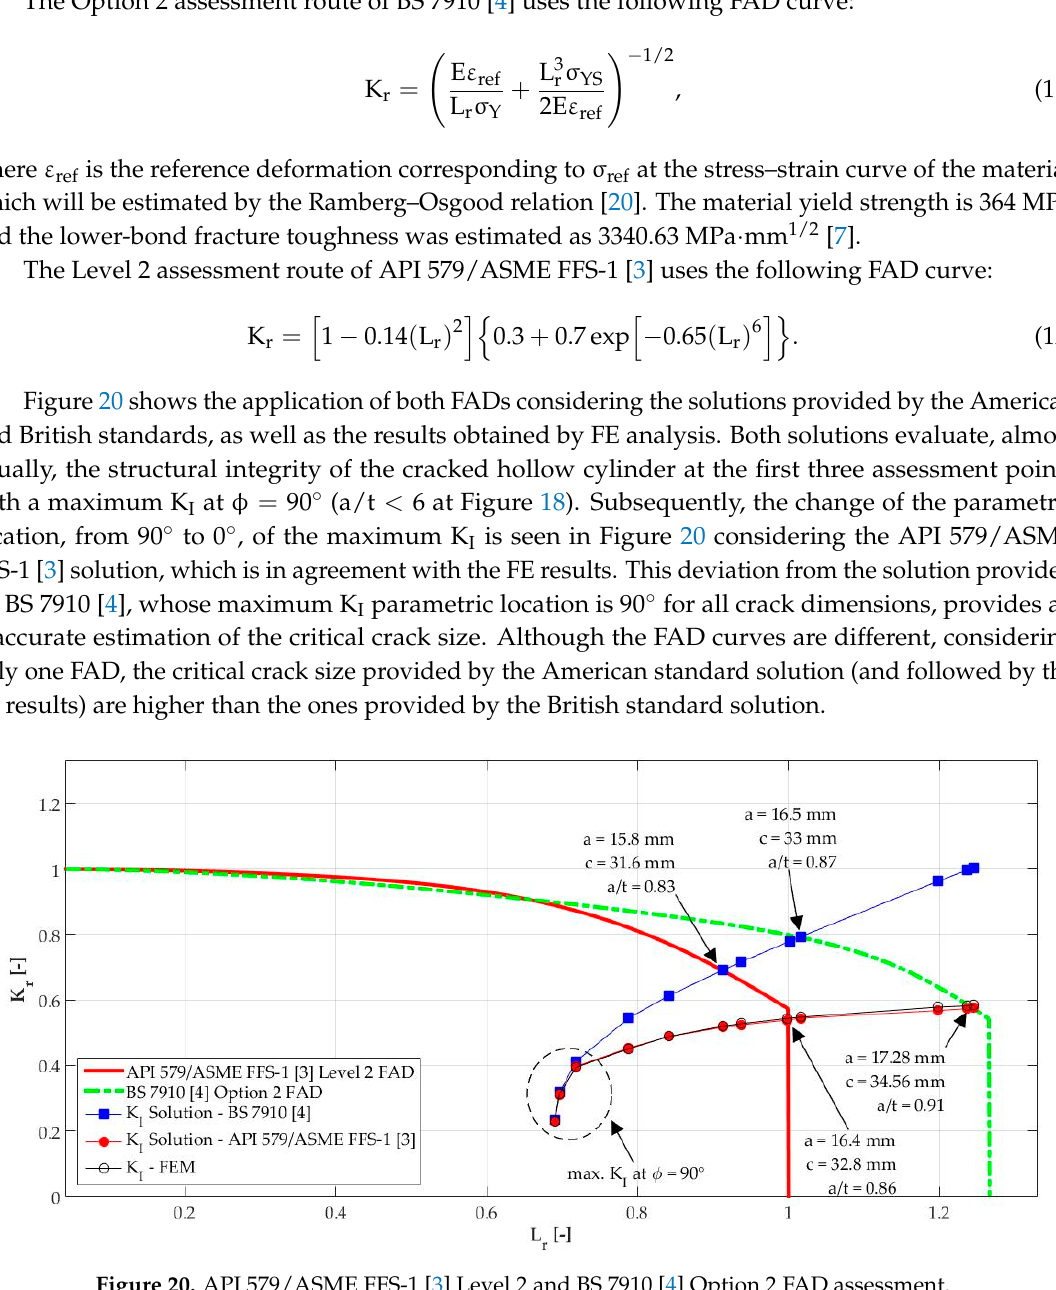
Figure 20. API 579/ASME FFS-1 [3] Level 2 and BS 7910 [4] Option 2 FAD assessment.